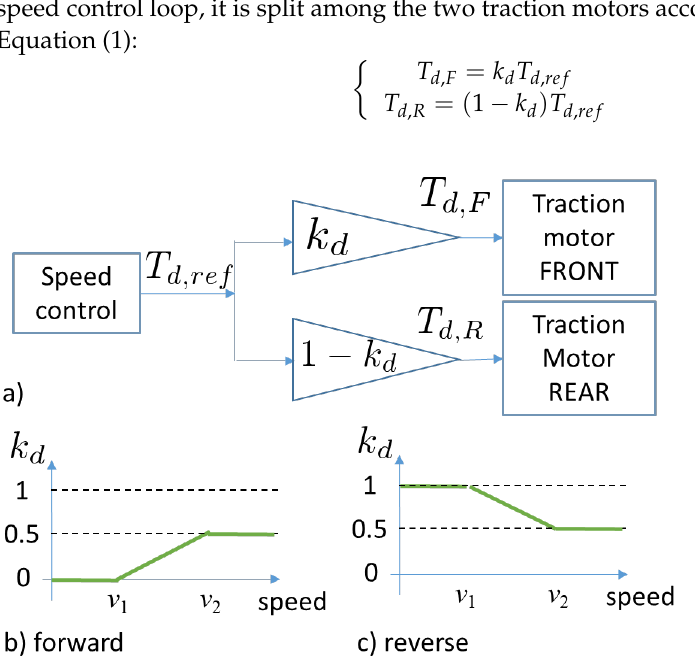
Figure 3. Front to rear driving torque distribution as a function of speed and the direction of motion scheme ( a ). Repartition coefficient in forward ( b ) and reverse ( c ) condition.